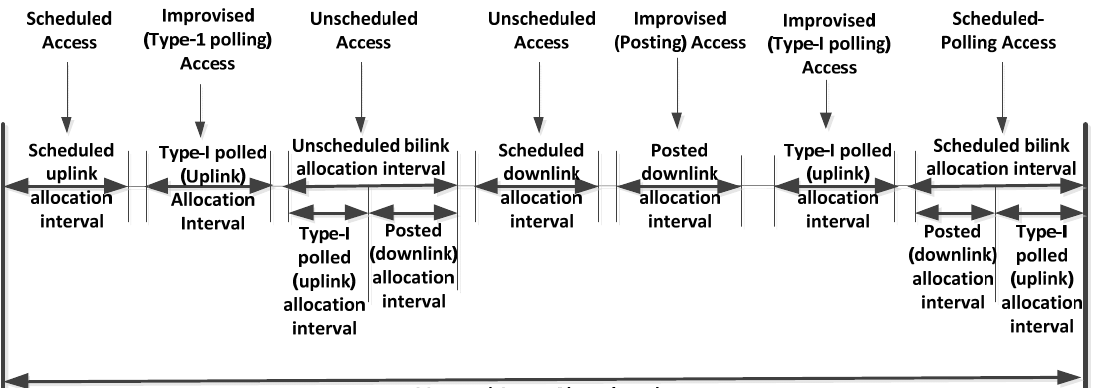
Figure 10. Allocation Interval and Access Methods Available in Managed Access Phase